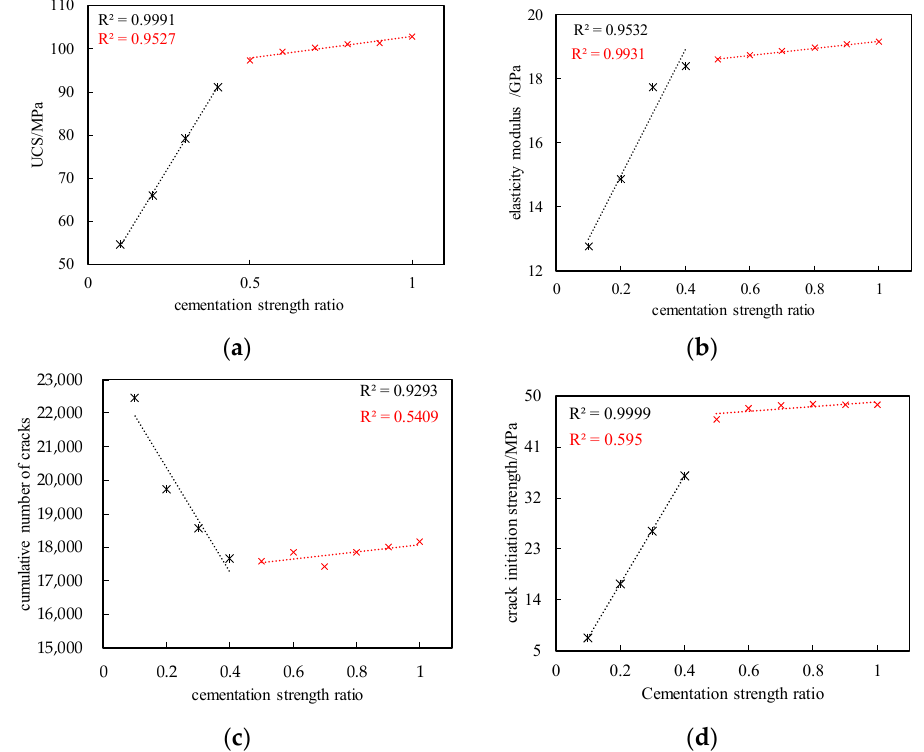
Figure 6. Influence of different cementation strengths on mechanical parameters and cumulative number of cracks. ( a ) Ratio of compressive strength to cementation strength; ( b ) Ratio of elastic modulus to bond strength; ( c ) Ratio of cumulative number of cracks to cementation strength; ( d ) Ratio of crack initiation strength to cementation strength.